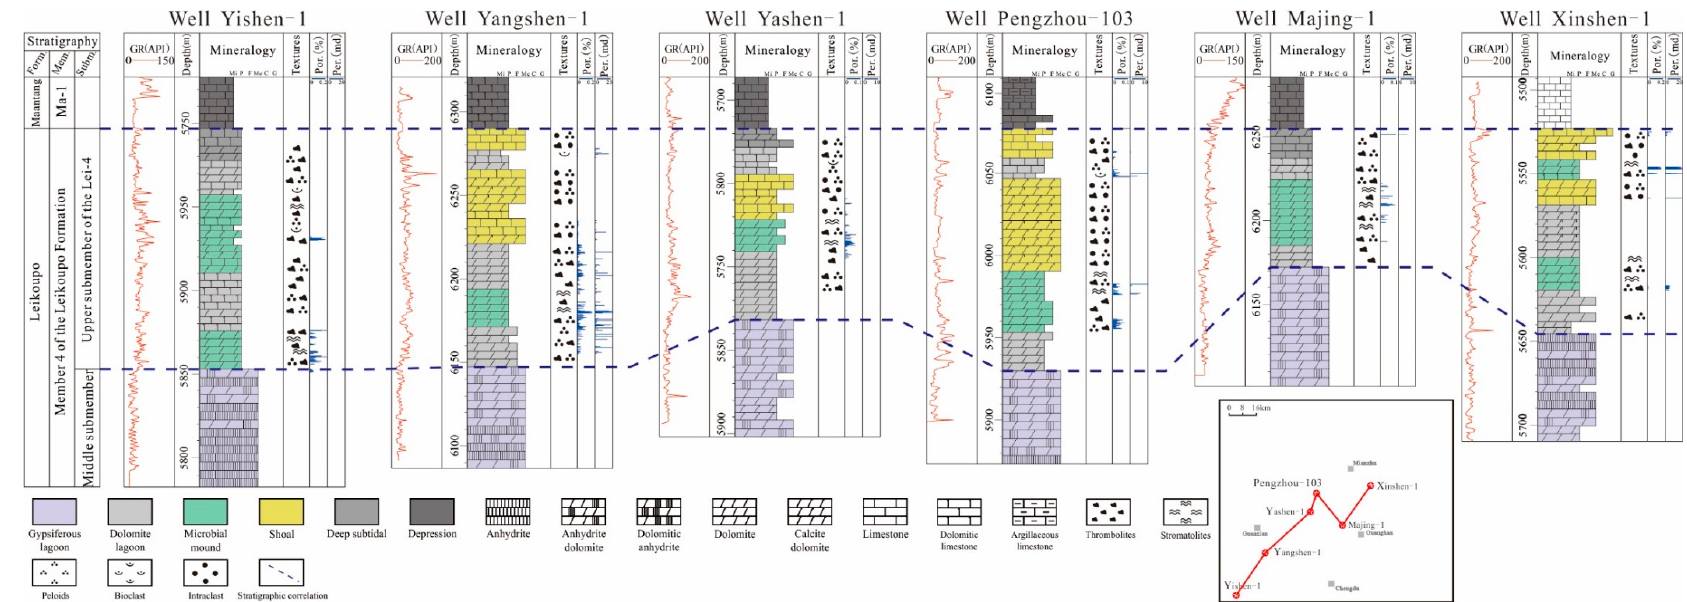
Figure 11. Mineralogy, textures, facies, porosity, and permeability of the middle and upper sub-member of the fourth member of the Leikoupo Formation.